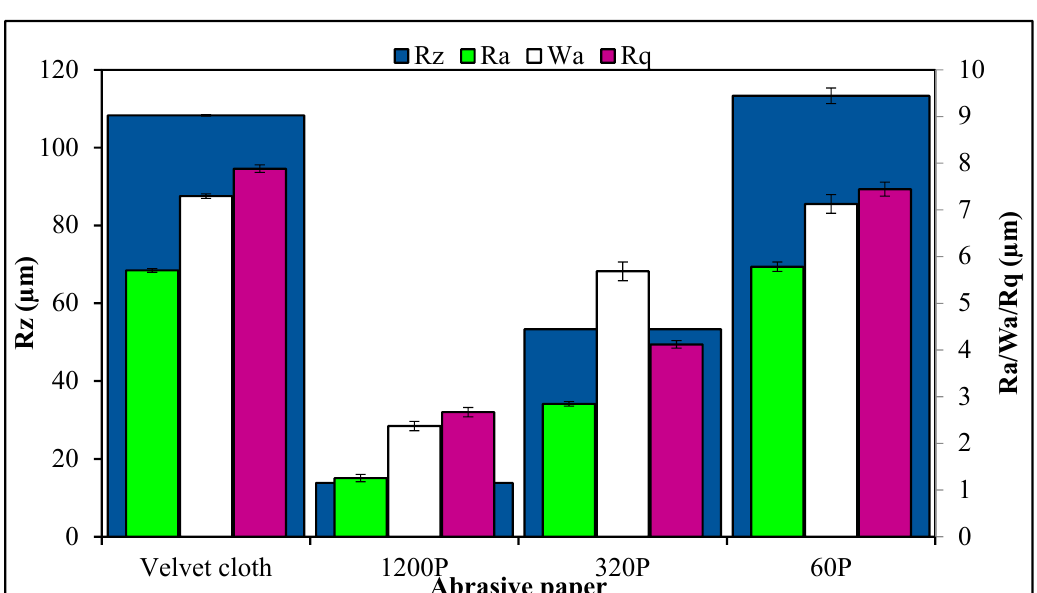
Figure 3. Surface roughness parameters of abrasive papers. Figure 4. Surface roughness parameters of abrasive